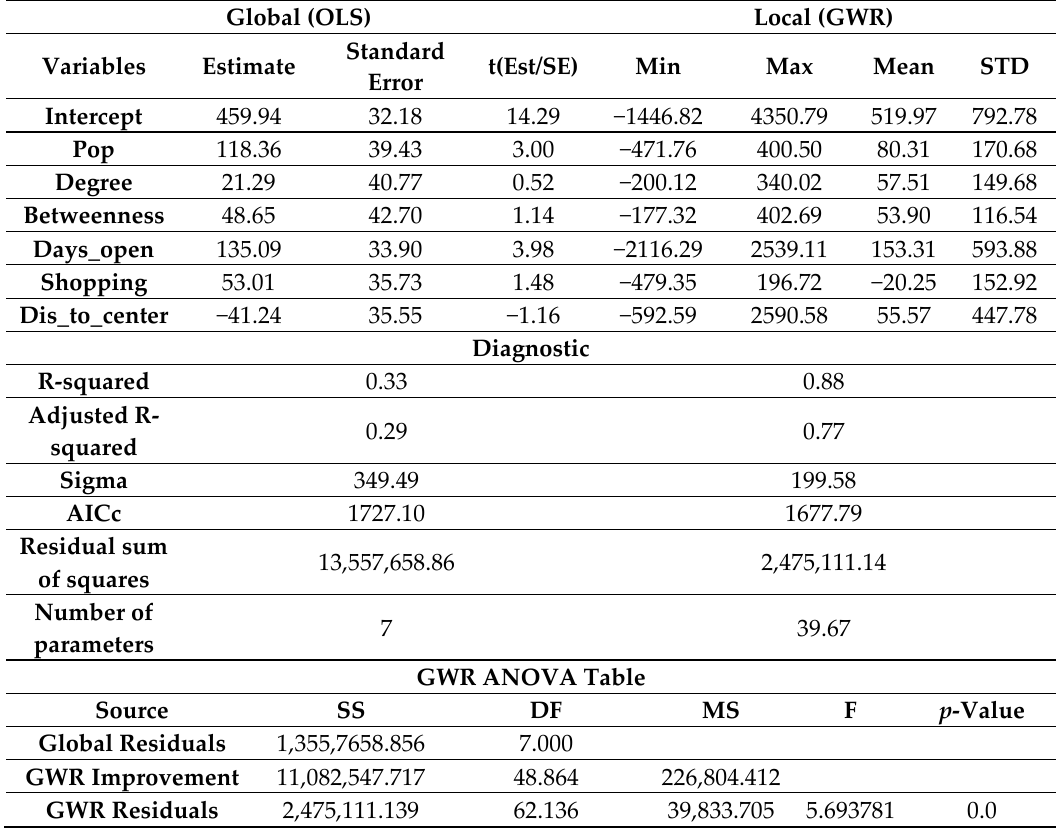
Table 5. Results of the model for Nonrush_ridership.